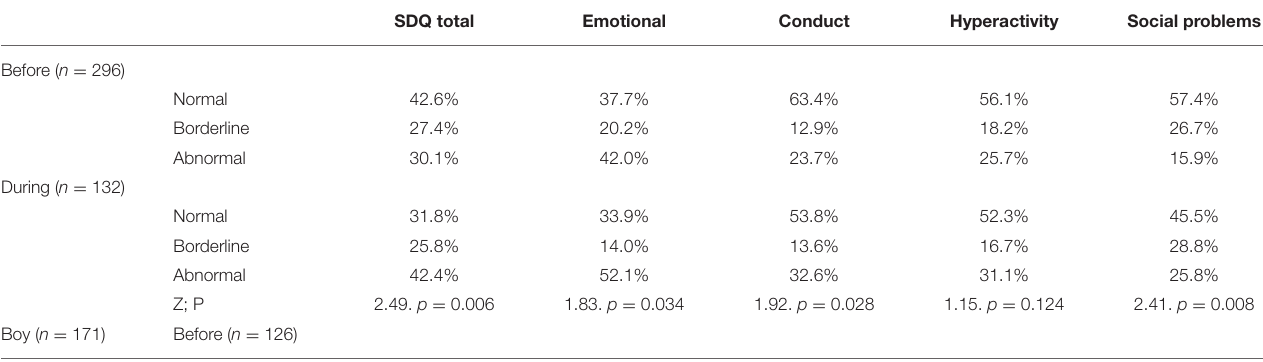
TABLE 5 | Prevalence of normal and abnormal reports on SDQ subscales before vs. during the COVID-19 pandemic, stratified by gender and